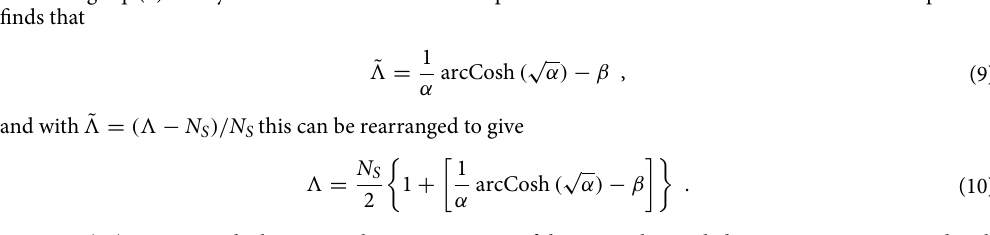
21, 51, 201, 10001 , for the number of infected people, I Figure 4. Simulation data, for P = n , together with their associated hyperbolic-tangent data interpolations rescaled iteration step ˜